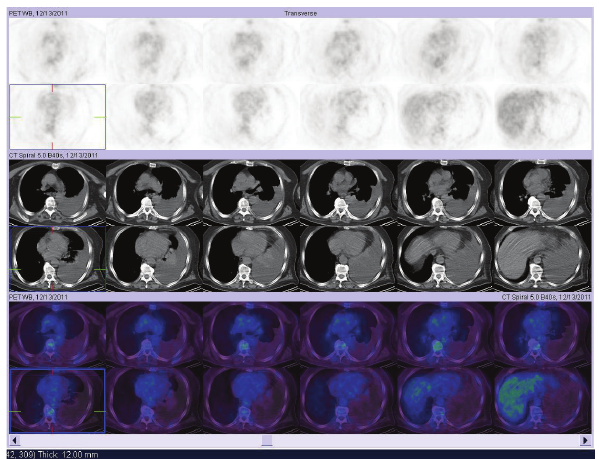
Figure 3: After six cycles of chemotherapy, PET/CT revealed nearly complete response of mediastinal